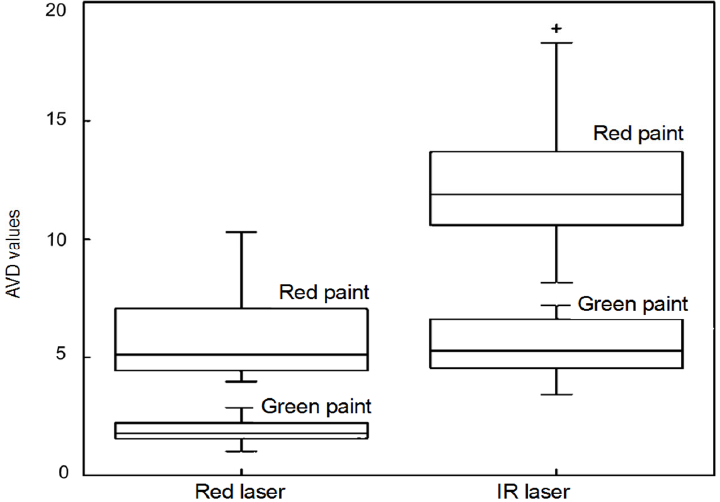
Figure 5. DLS measurements of drying paints addressed by the AVD index using red laser and IR laser. Results were obtained the first five minutes after application of the paint.